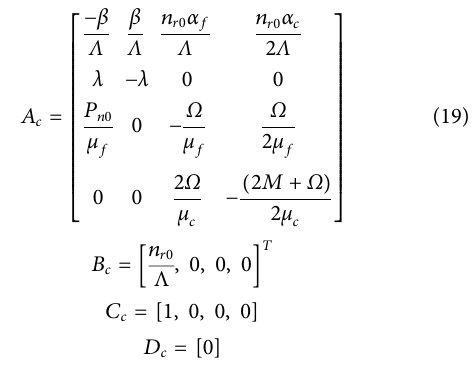
De fi nition ofthe fi vemembershipfunctions M 1 to M 5 (Acolor version of the fi gure is kindly referred to the online version of the